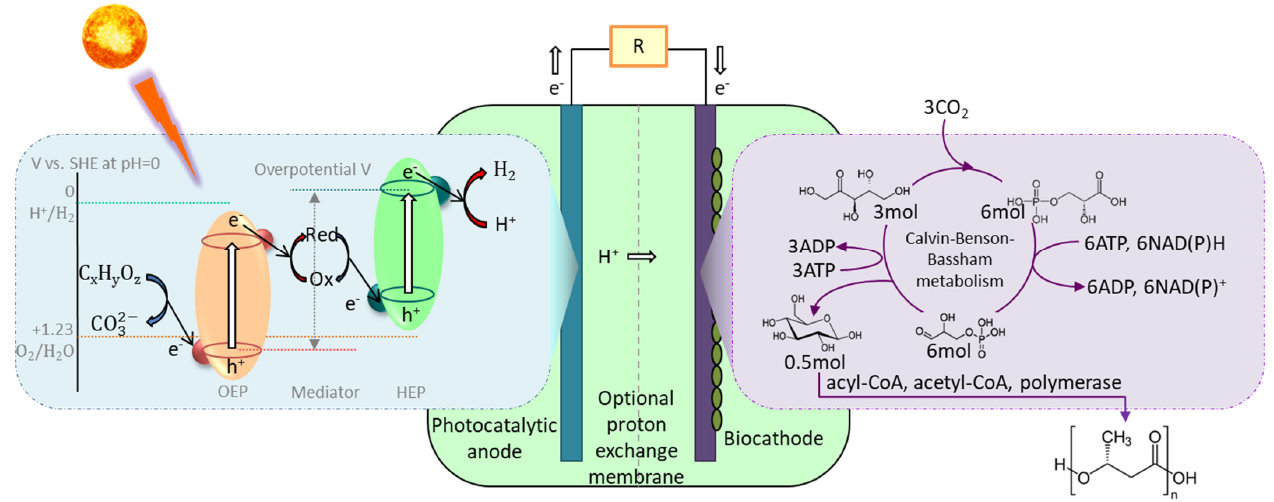
Figure 2. Integrated photocatalytic bio-electrosynthesis system. OEP: oxygen evolution photocatalyst. HEP: hydrogen evolution photocatalyst. Mechanistic illustration of photo-excited electron transfer from the valence band to the conduction band through redox reactions in the photocatalyst evolving hydrogen ( left ) and biocatalytic CO 2 reduction in Calvin–Benson–Bassham autotrophic metabolism to poly(3-hydroxybutyrate) biosynthesis ( right ).